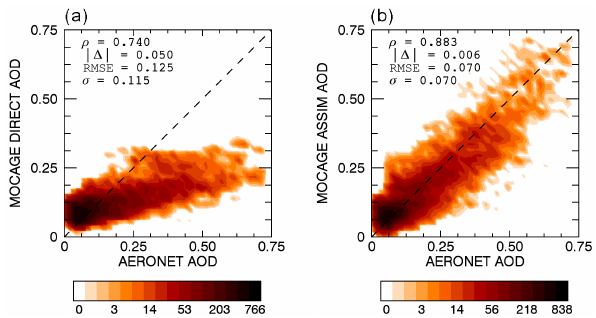
Figure 7. Scatter plots of aerosol optical depths (where colours represent the number of points) from the independent observation dataset (AERONET) and the simulations: the direct model run (a) and the assimilation model run (b) . In each panel, correlation ( ρ ), absolute bias ( (cid:49) ), root mean square error (RMSE) and standard de- viation ( σ ) are noted. The included data correspond to the period of the TRAQA campaign from 25 June until 13 July 2012, and covers all stations presented in Fig.